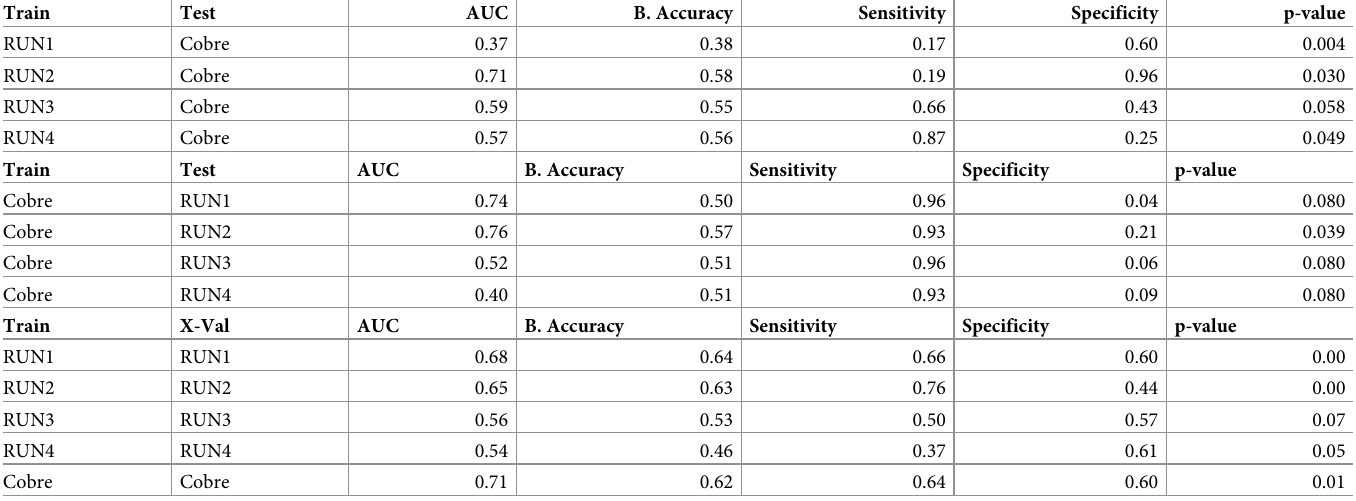
Table 4. Results of out of sample testing for each HCPEP